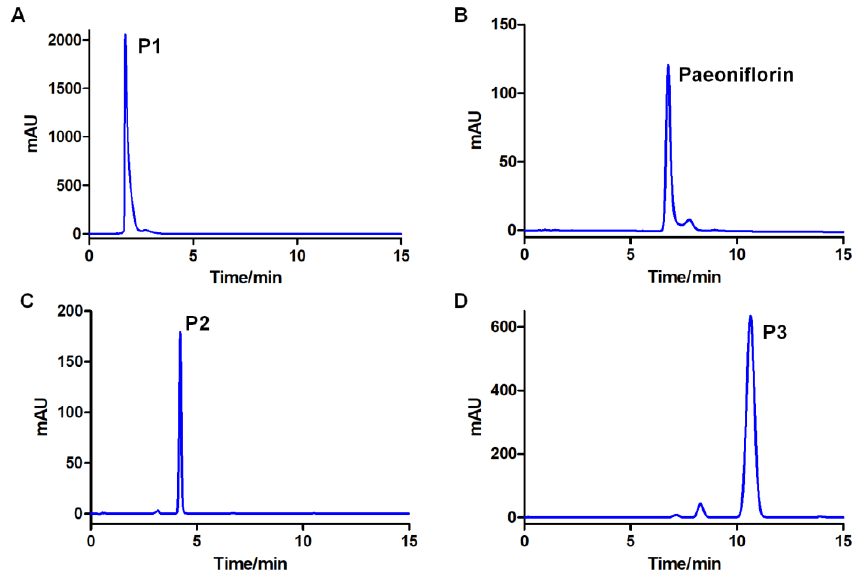
Figure 8. HPLC-DAD chromatograms of paeoniflorin conversion products. Conditions are the same as in Figure 6. ( A – D ) are DAD chromatograms of P1, paeoniflorin, P2, and P3, respectively. The purity of P2 was 99.81%, and the purity of P3 was